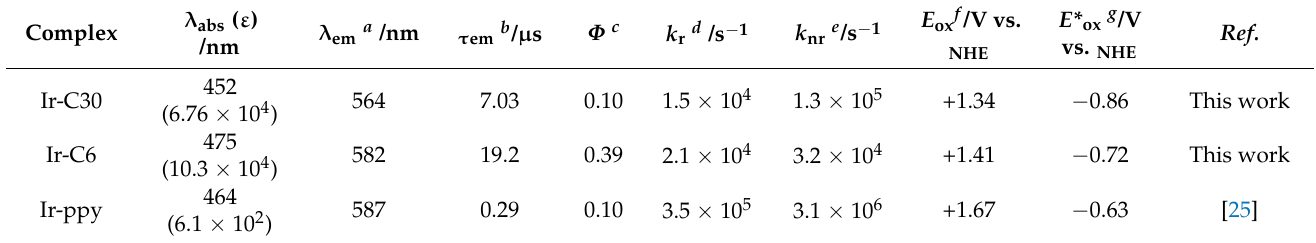
Table 1. Comparison of the photophysical and electrochemical data of Ir-C30, Ir-C6, and Ir-ppy.